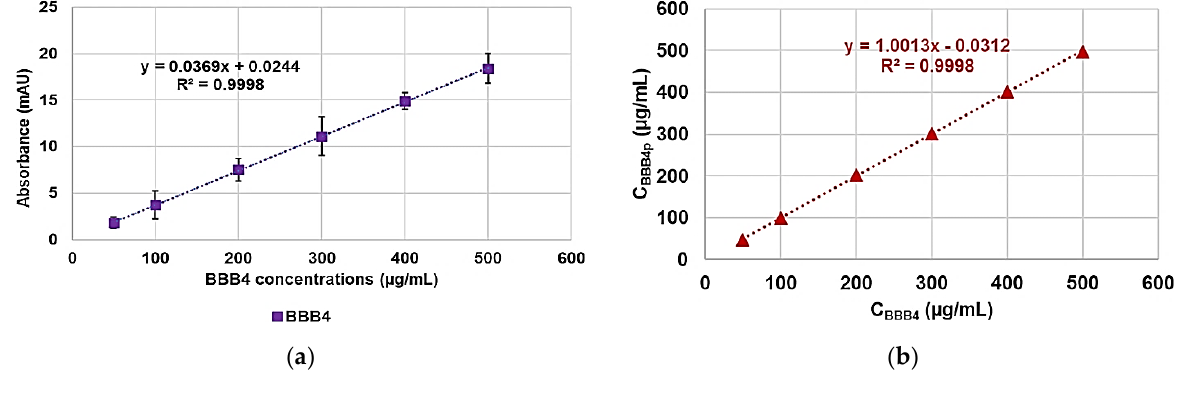
Figure 9. BBB4 linear calibration model ( a ); C BBB4p vs. C BBB4 ( b